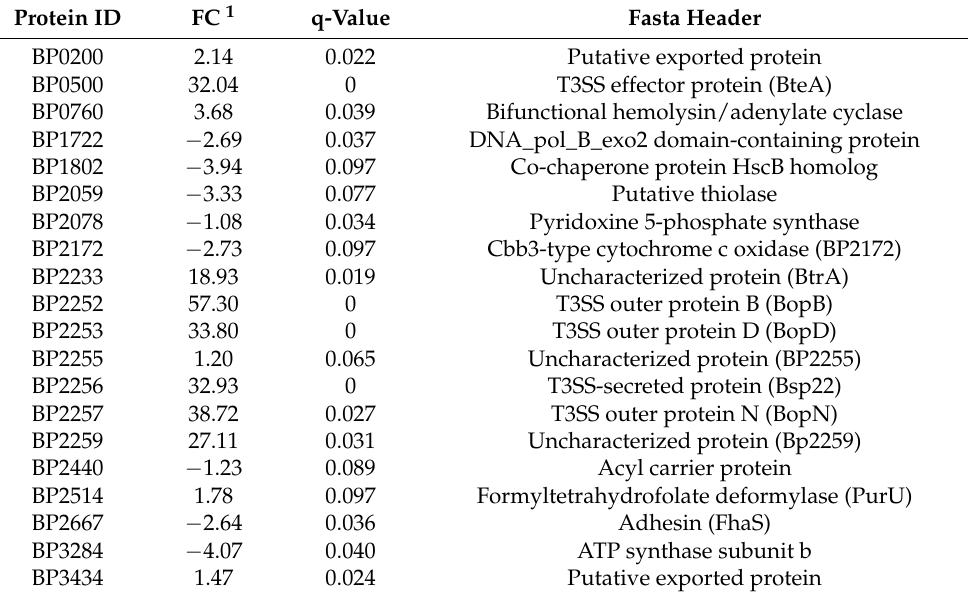
Table 2. List of proteins significantly differentially secreted upon previous exposure to